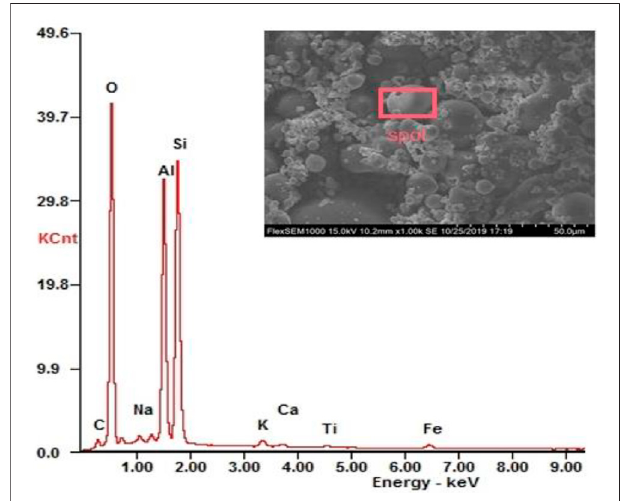
FIGURE 1 | SEM-EDS of fl y